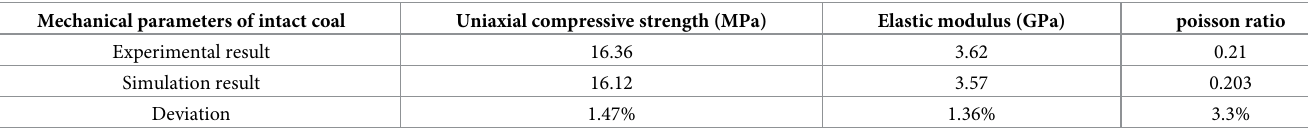
Table 1. Mechanical parameters of intact specimens obtained from laboratory test and numerical